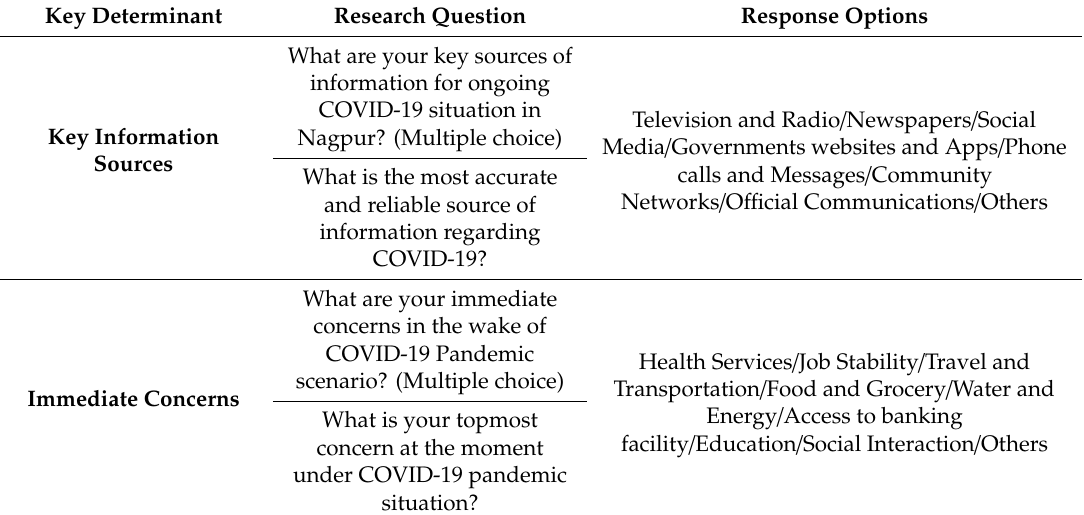
Table 1. Research Questions for assessment of “Key Information Sources” and “Immediate